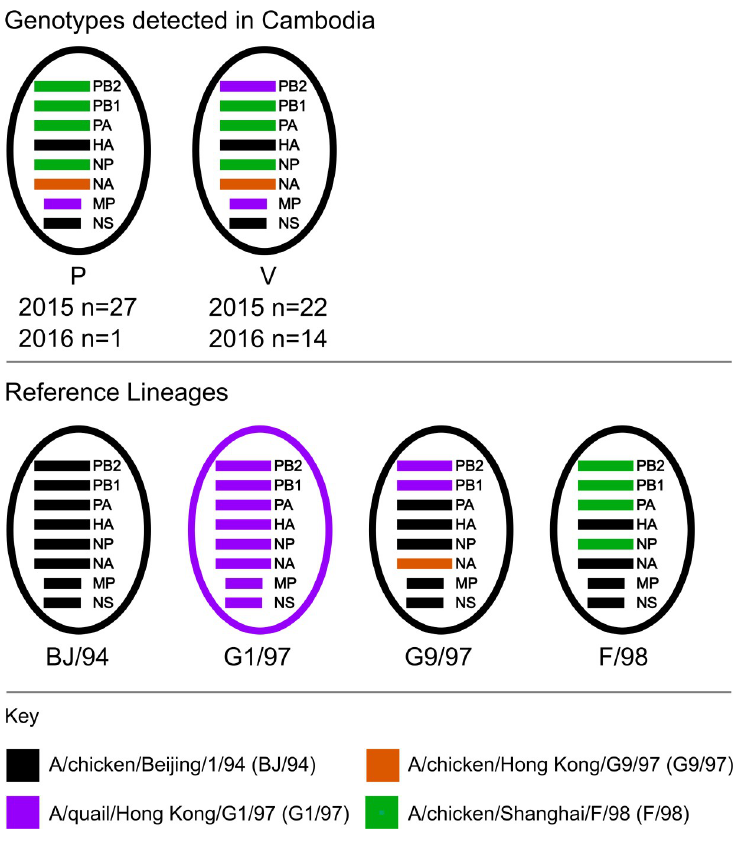
Fig 4. Genotypes of A(H9N2) Cambodian viruses detected from 2015 to 2016. The eight genomic segments are colour coded based on the putative ancestral reference AIVs. The genomic constellations of relevant reference lineage viruses (BJ/94, G1/97, G9/97 and F/98) are shown in the bottom panel. Segments from BJ/94 viruses are shown in black, G1/97 in purple, G9/97 in orange and F/98 in